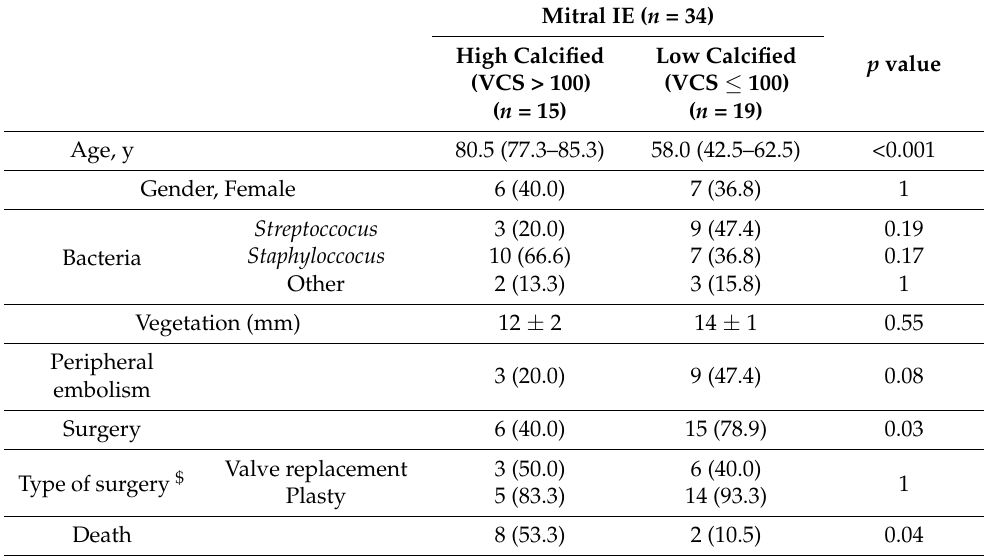
Table 2. Characteristics of patients with mitral IE in function of mitral valvular calcium score (VCS).